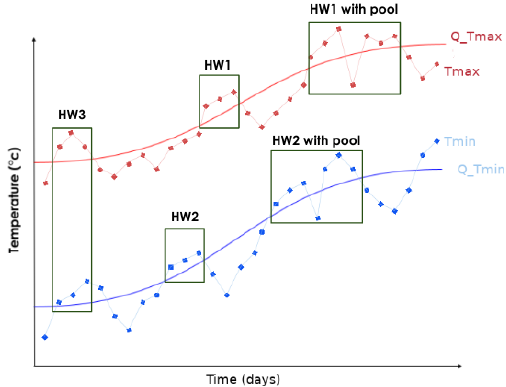
Figure 2. Schematic illustration of heat wave detection process: HW1/HW2 represents heat waves associated with maximum/mini- mum temperature and HW3 is heat waves detected at the same time in maximum and minimum temperatures. The red/blue lines with squares are max/min daily temperatures. Solid red/blue lines are max/min thresholds. The x and y axes represent the time in days and the temperature in degrees Celsius respectively. The term “with pool” refers to the pooling of two (or more) events separated by 1d below the daily threshold. This figure shows the different types of heat wave investigated in this